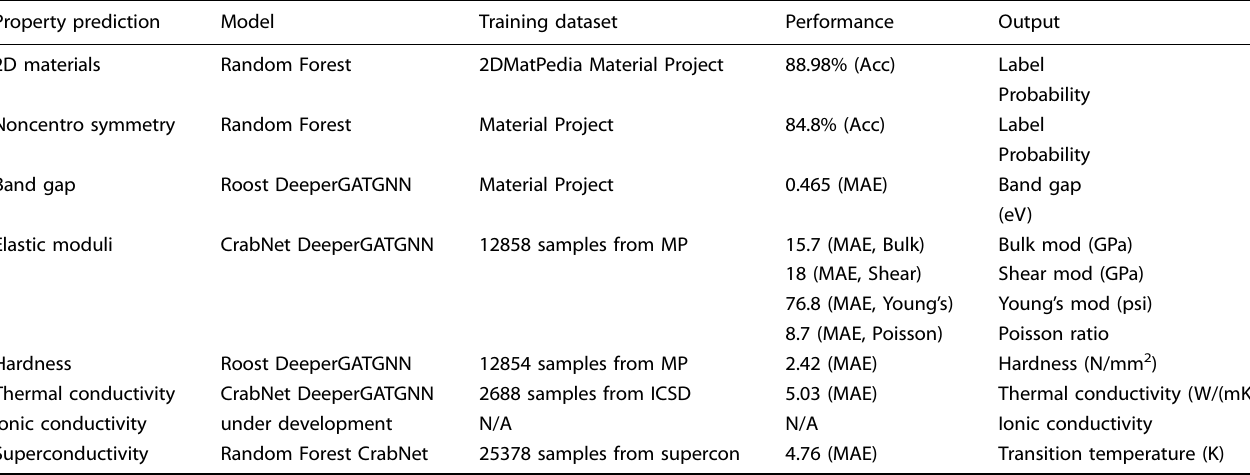
Table 3. Summary of materials property prediction